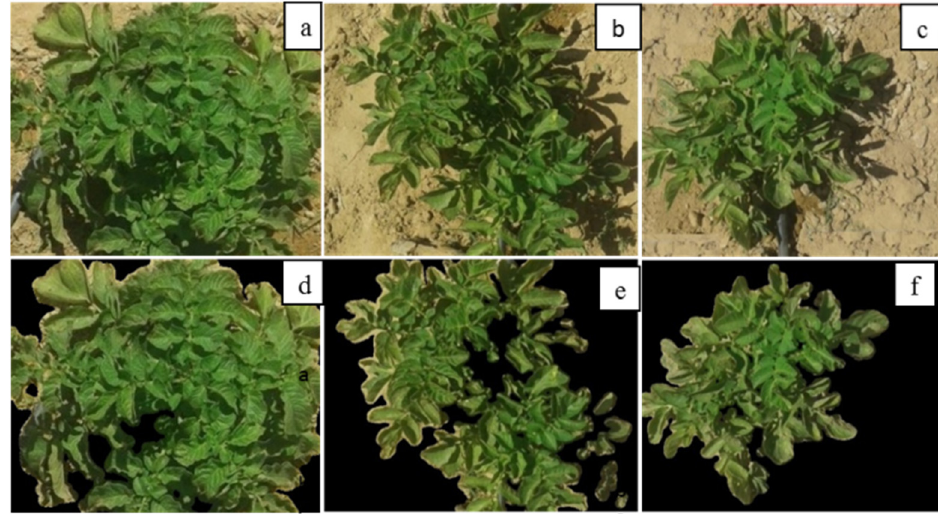
Figure 2. Original photos for ( a ) 100%, ( b ) 75% and ( c ) 50% ETc as well as segmentation photos for ( d ) 100%, ( e ) 75% & ( f ) 50% ETc.